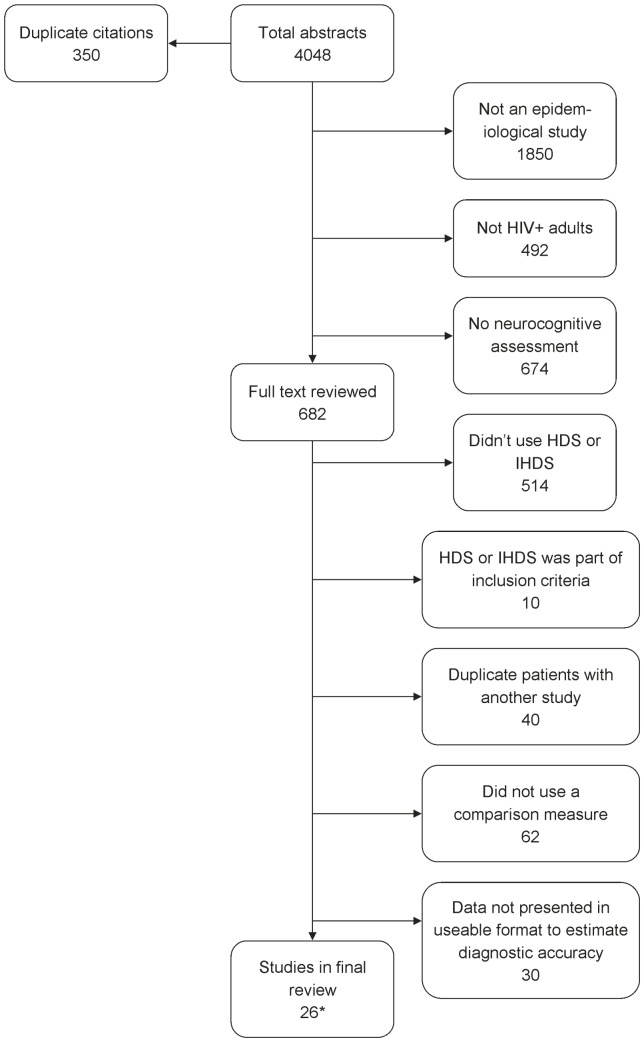
Systematic review flowchart.Footnote: * Of the final 26 studies in the review, one comprised two separate populations [10], which are treated as two different studies in all further analyses.